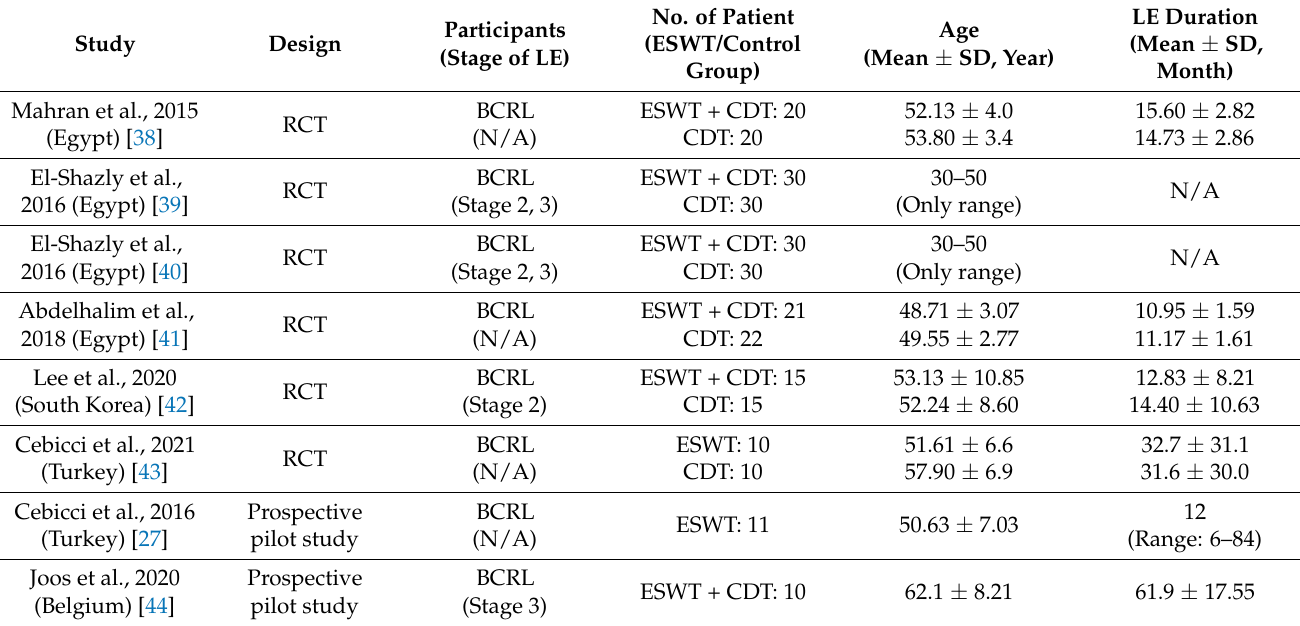
Table 2. Patients ’ characteristics of included studies.